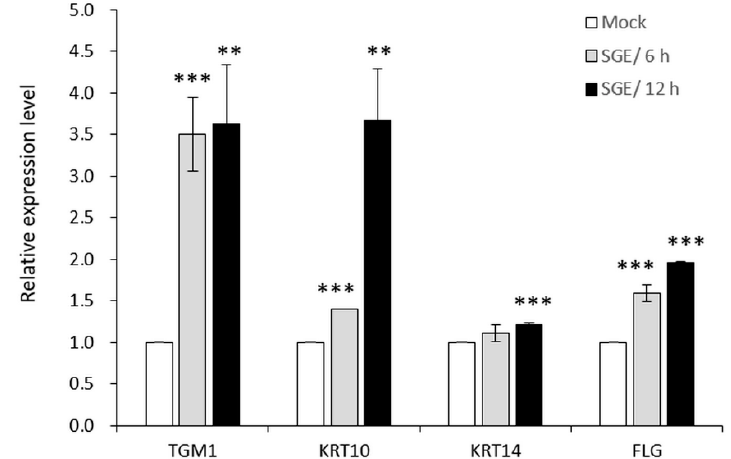
Figure 6. SGE induced moisturizing-related gene expressions in human primary epidermal keratinocytes. Cells were treated with 0.03125 mg/ml SGE for 6 hours (grey bar) or 12 hours (black bar), or left untreated for 12 hours as a control (Mock, white bar). After treatment, cells were harvested for TGM1 , KRT10 , KRT14 and FLG gene expression analysis. **, P < 0.01 versus Mock; ***, P < 0.001 versus Mock. SGE, Sargassum glaucescens